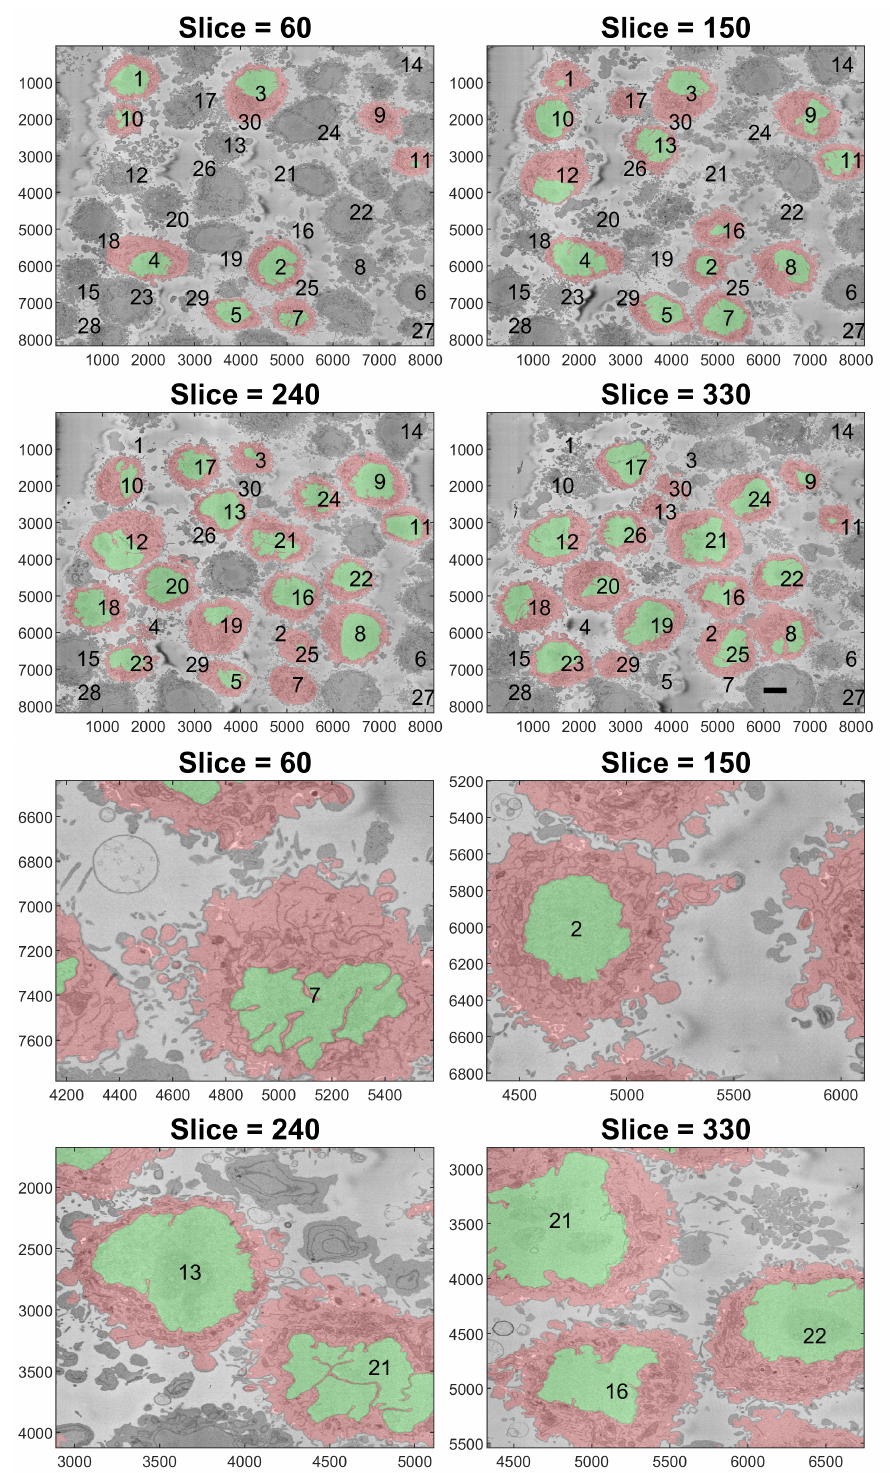
Figure 10. Final illustration of the results in four representative slices. Cells are highlighted with a red shade, and the nuclei are highlighted with a green shade. Numbers were added to aid the localisation of the particular cell. Notice that some of the numbers corresponded to cells that were not visible in that particular slice. The units of the axes are in pixels, and a scale bar indicating 5 µ m is shown in Slice 330 on the top. The bottom shows a magnified version of the